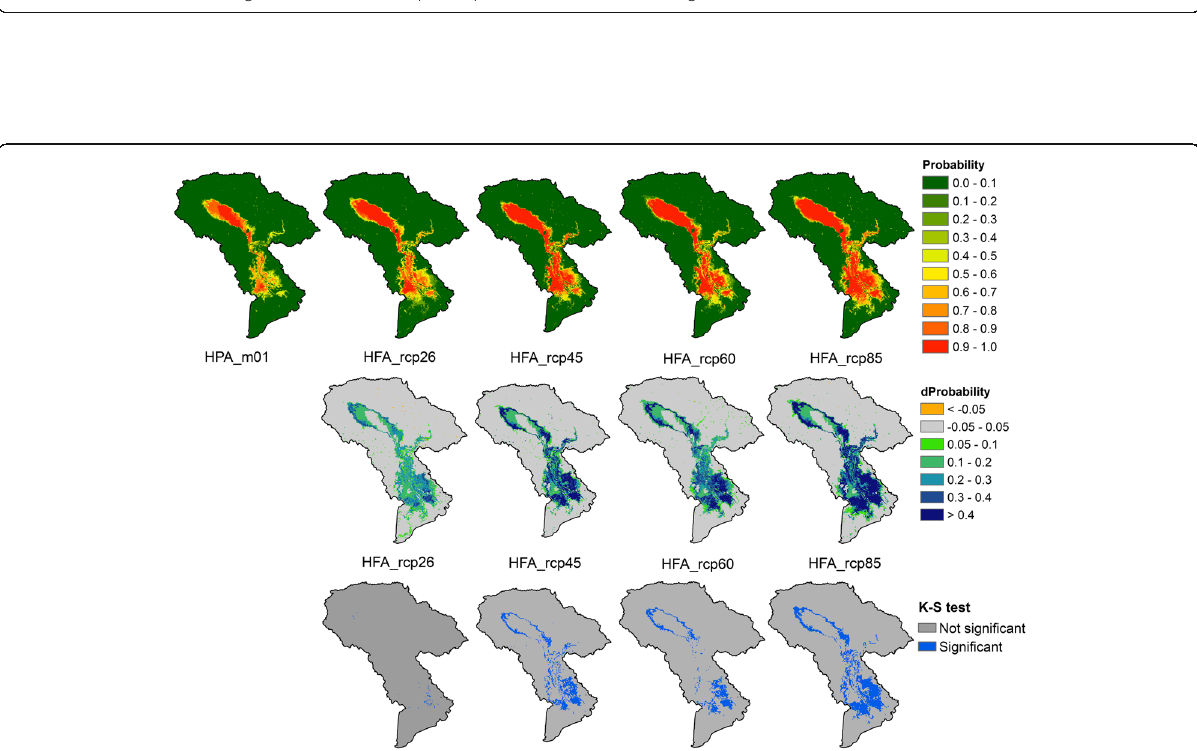
Fig. 9 Spatial distribution of inundation probability (upper row), difference between present and each future RCP scenarios (middle row), and K-S test (lower row) for MRI-AGCM3.2H